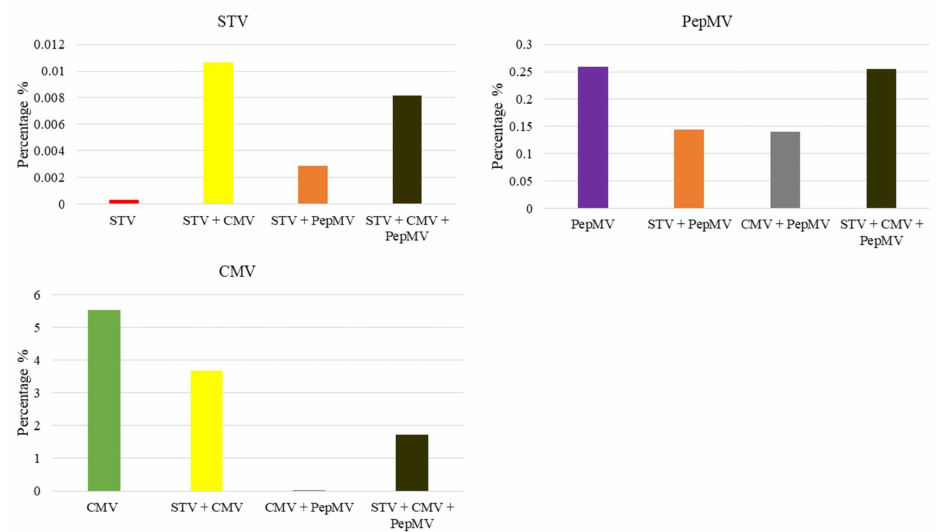
Figure 5. Graphic representation of the percentages (%) of vsiRNAs respect to the useful reads obtained by small RNA high throughput sequencing of the different STV, CMV, and PepMV virus combinations. The percentages of vsiRNAs were obtained from the useful reads mean values of the three biological